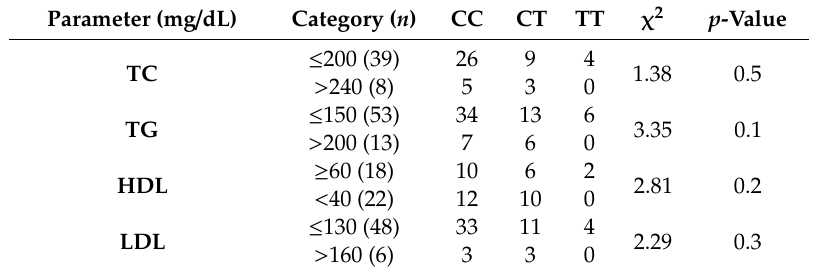
Table 7. Relationship between FokI polymorphism genotypes and lipid profile parameters in controls ( n =